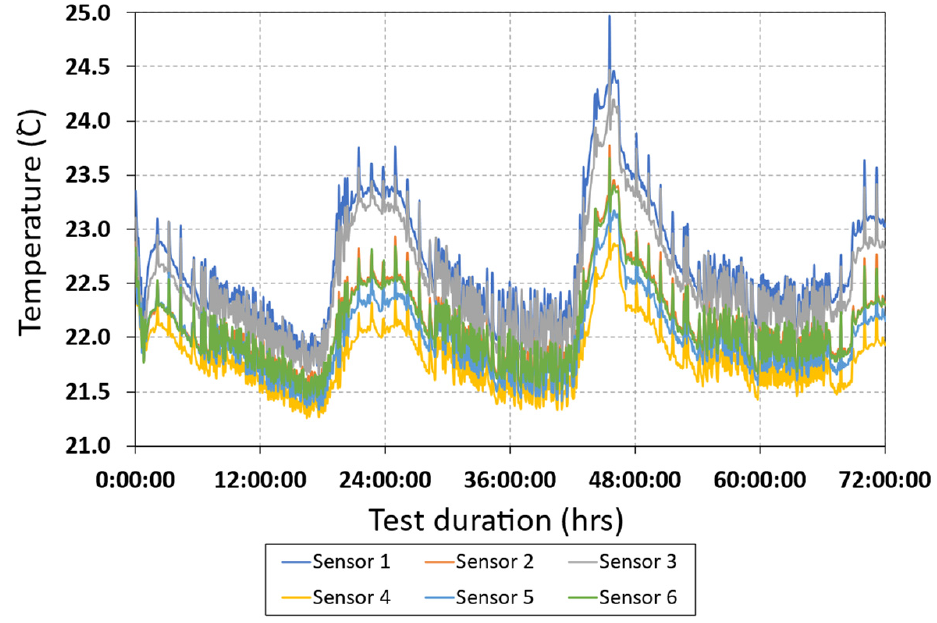
Figure 7. Laboratory temperature